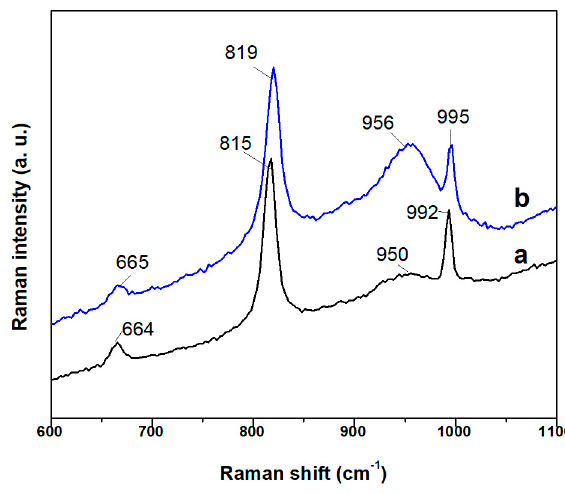
Figure 4. Laser Raman spectra of Mo/AT2 catalyst calcined at 673 K with different Mo loadings: ( a ) 10 wt.%, ( b ) 15 wt.%.